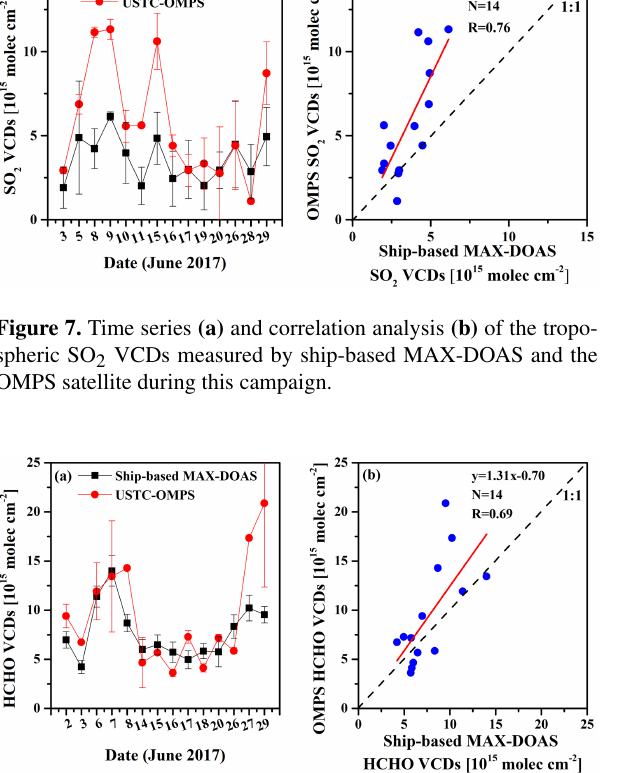
Figure 8. Time series (a) and correlation analysis (b) of the tro- pospheric HCHO VCDs measured by ship-based MAX-DOAS and the OMPS satellite during this